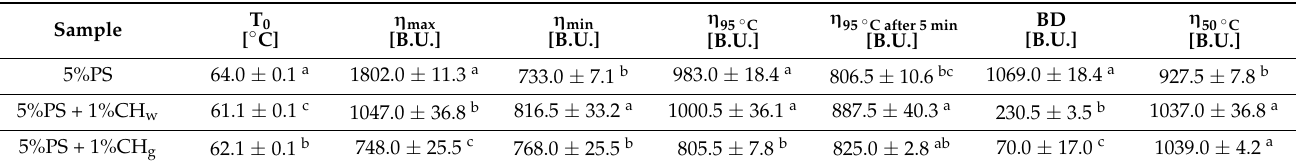
Table 1. Pasting characteristics of 5% PS and PS with an addition of 1% of CH (whole and ground